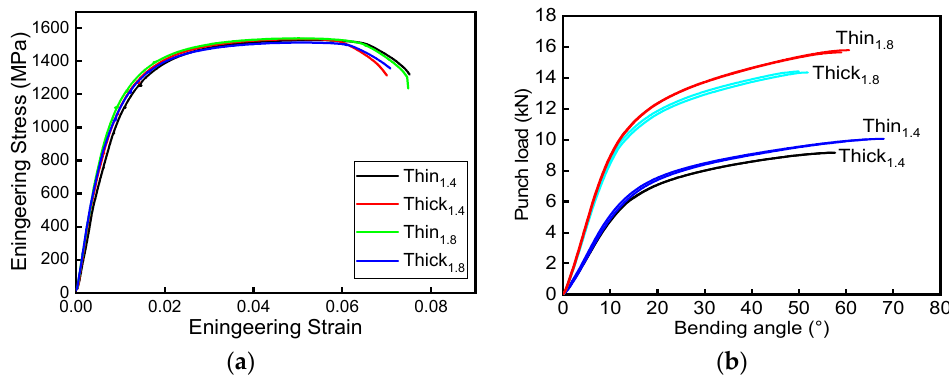
Figure 7. Mechanical properties of the four studied Al–Si-coated steels: ( a ) tensile properties; ( b ) bending results.